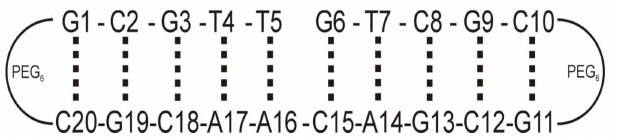
Scheme 2. Schematic representation of the biological target in the nicked DNA duplex in a